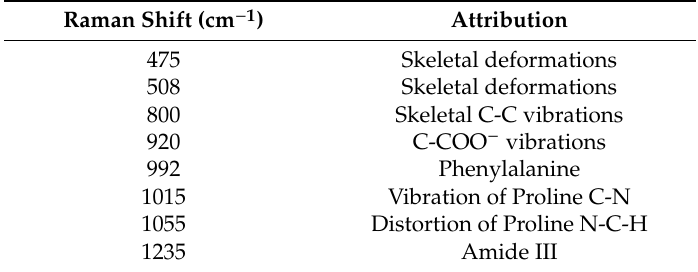
Table 1. Potential peaks attribution, based according to Carcamo et al.